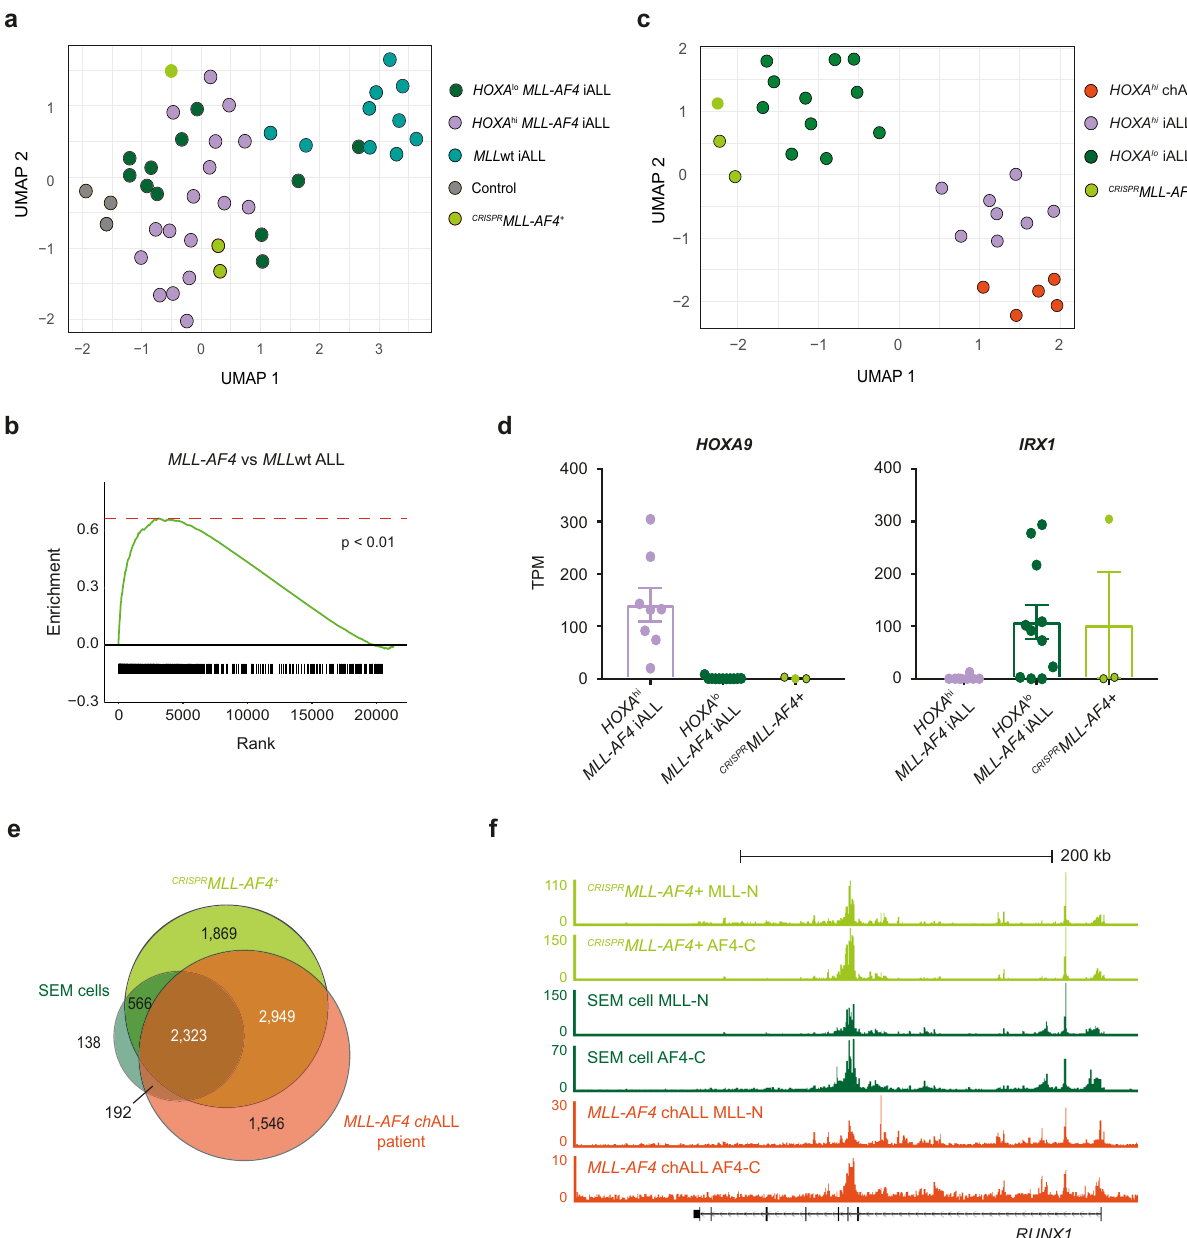
Fig. 4 CRISPR MLL-AF4 + ALL recapitulates the molecular pro fi le of MLL-AF4 ALL in patients. a UMAP showing clustering of CD19 + cells from CRISPR MLL- AF4 + (light green; black border = proB ALL, no border = preB-ALL) and control (gray) mice with HOXA lo MLL-AF4 (dark green, n = 11), HOXA hi MLL-AF4 (purple, n = 20), and MLL wt (blue, n = 9) infant-ALL patient samples from a publicly available dataset 27 based on 7041 signi fi cantly differentially expressed genes (FDR < 0.05, edgeR glm test) between CRISPR MLL-AF4 + ALL, controls, MLL-AF4 infant-ALL, and MLL wt infant-ALL. b Gene set enrichment analysis (GSEA) 52 showing CRISPR MLL-AF4 + ALL is more enriched for genes that are upregulated in MLL-AF4 ALL compared to MLL wt ALL (1000 genes) when compared to CD19 + cells from control mice ( p < 0.01). c UMAP showing clustering of CRISPR MLL-AF4 + (light green; black border = proB ALL, no border = preB-ALL) with HOXA lo MLL-AF4 (dark green, n = 11) HOXA hi MLL-AF4 infant-ALL (purple, n = 8), and HOXA hi MLL-AF4 childhood-ALL (orange, n = 5) from a publicly available patient dataset 23 based on 765 signi fi cantly differentially expressed genes (FDR < 0.05; edgeR glm test) between these three patient subsets (Supplementary Data 3). d Expression (TPM) of HOXA9 and IRX1 in HOXA hi MLL-AF4 infant-ALL (purple, n = 8), HOXA lo MLL-AF4 infant-ALL (dark green, n = 11) and CRISPR MLL-AF4 + ALL (light green; black border = proB ALL, no border = preB ALL). Data are shown as mean ± SEM. Source data are provided as a Source Data fi le. e Venn diagram showing overlap of MLL-AF4-bound genes (genes with an MLL-AF4 peak in the gene body) in CRISPR MLL-AF4 + ALL in a primary recipient mouse, the MLL-AF4 + SEM cell line and a primary MLL-AF4 childhood-ALL (chALL) patient sample. MLL- AF4 peaks = directly overlapping MLL-N and AF4-C peaks. f Representative ChIP-seq tracks at the MLL-AF4 target gene, RUNX1 in CRISPR MLL-AF4 + ALL, the SEM cell line and a primary MLL-AF4 childhood-ALL (chALL) patient